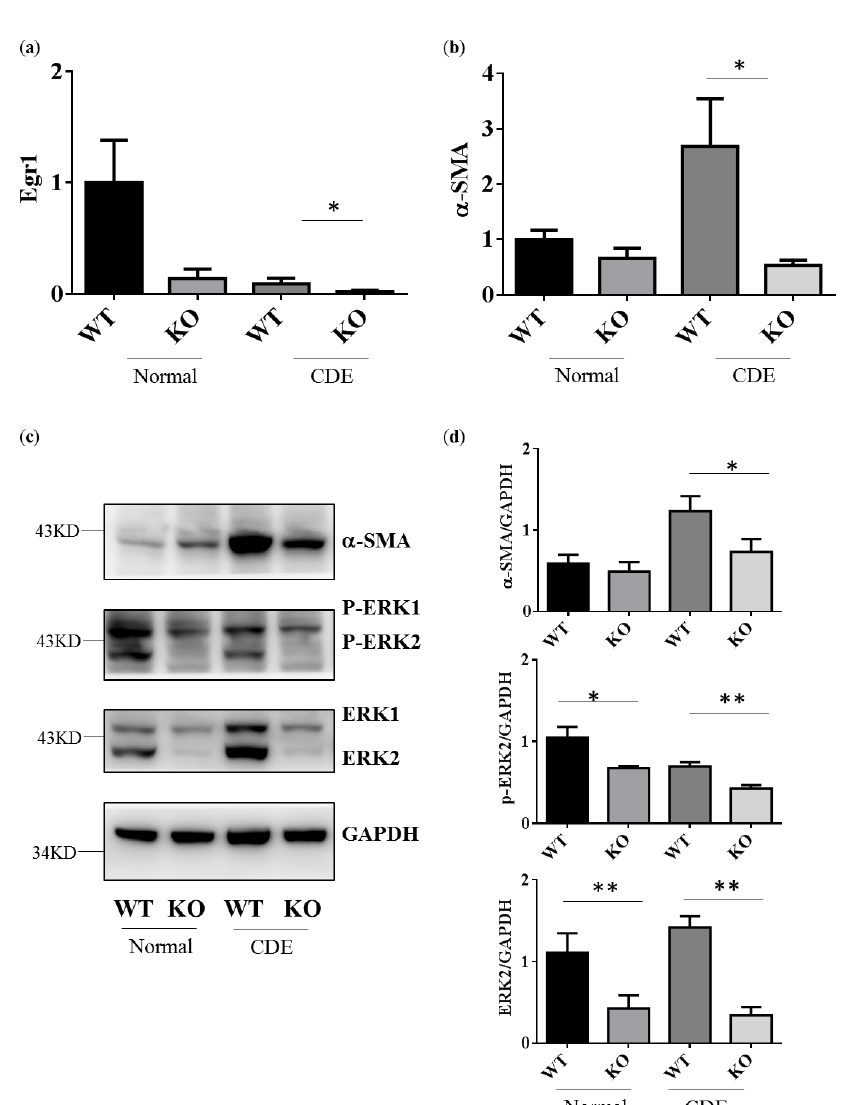
Figure 3. Erk2 −/− (KO) livers express less cirrhosis gene α-SMA than WT livers. Gene expression of Egr1 ( a ), alpha-SMA ( b ) were determined by QPCR. Data were normalized by the average of expression level in WT under the normal chew diet (WT, normal) as 1. Data were represented as mean +/− SE and were considered significant if * p < 0.05; ** p < 0.01. WT ( n = 4), KO ( n = 4); ( c ) WT and Erk2 −/− livers were subjected to Western Blotting and analyzed for protein expression in alpha-SMA, phospho-ERK (P-ERK1 and P-ERK2), ERK (ERK1 and ERK2) and loading control glyceraldehyde-3-phosphate dehydrogenase (GAPDH); ( d ) Protein expression were quantized by Image J and normalized by the expression of GAPDH. The relative protein expression level was shown. (WT n = 4; KO n = 4; * p < 0.05; ** p < 0.01).